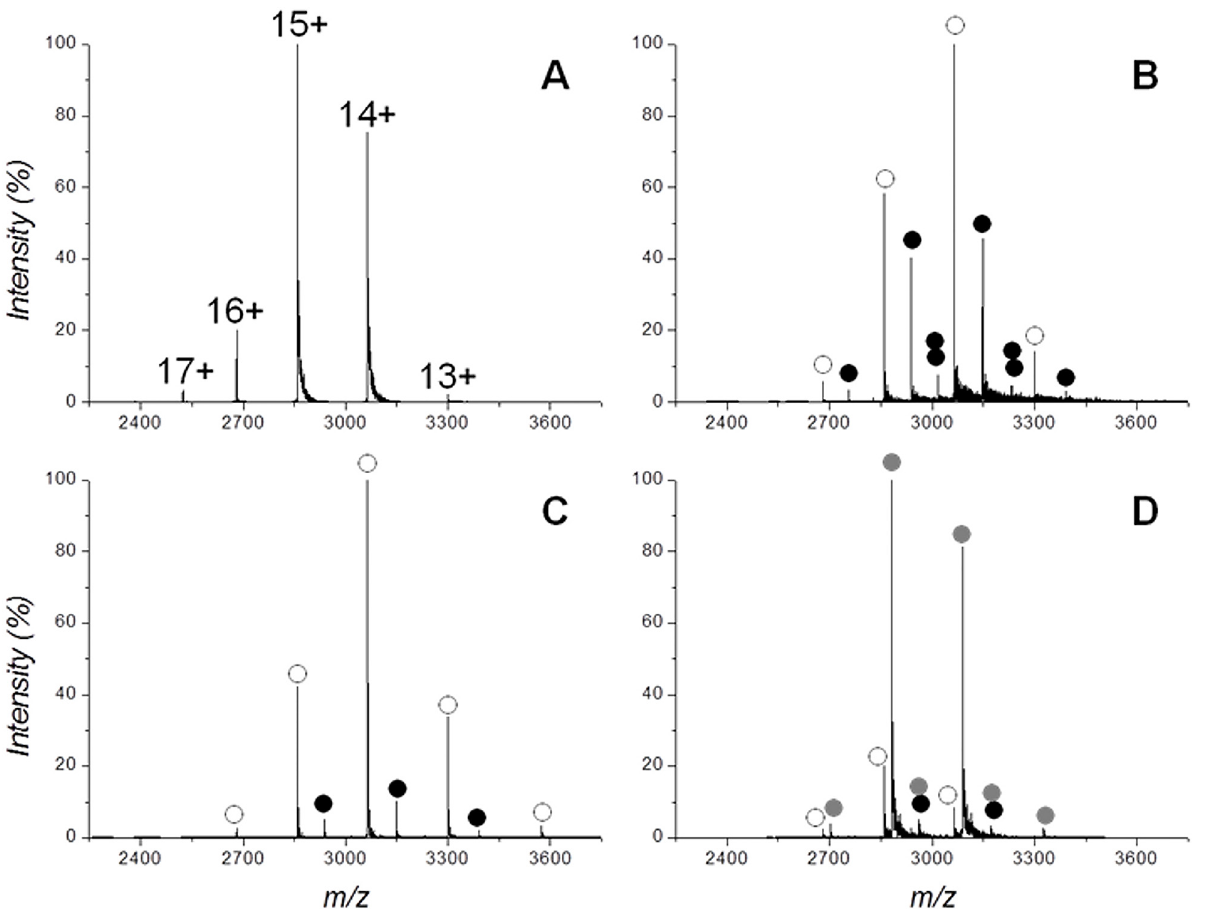
Fig 4. ESI-MS analysis of Protein-Peptide complexes. Spectra of 20 μ M MBP in 50 mM ammonium acetate pH7. (A) DP60 V, (B) DP 60 V in the presence of 20 μ M MBP-9, (C) DP 180 V in the presence of 20 μ M MBP-9, (D) DP 60 V in the presence of 20 μ M MBP-9 and 20 μ M maltose. In panel A the peaks are labeled by the charge acquired during the electrospray. In panels B-D the peaks corresponding to apoMBP ( (cid:4) ), MBP:MBP-9 1:1 complex ( (cid:129) ), MBP:MBP-9 1:2 complex ( (cid:129)(cid:129) ), MBP:maltose 1:1 complex (gray solid circle) and MBP:MBP-9:maltose: 1:1:1 complex (black/gray solid circles) are labeled.